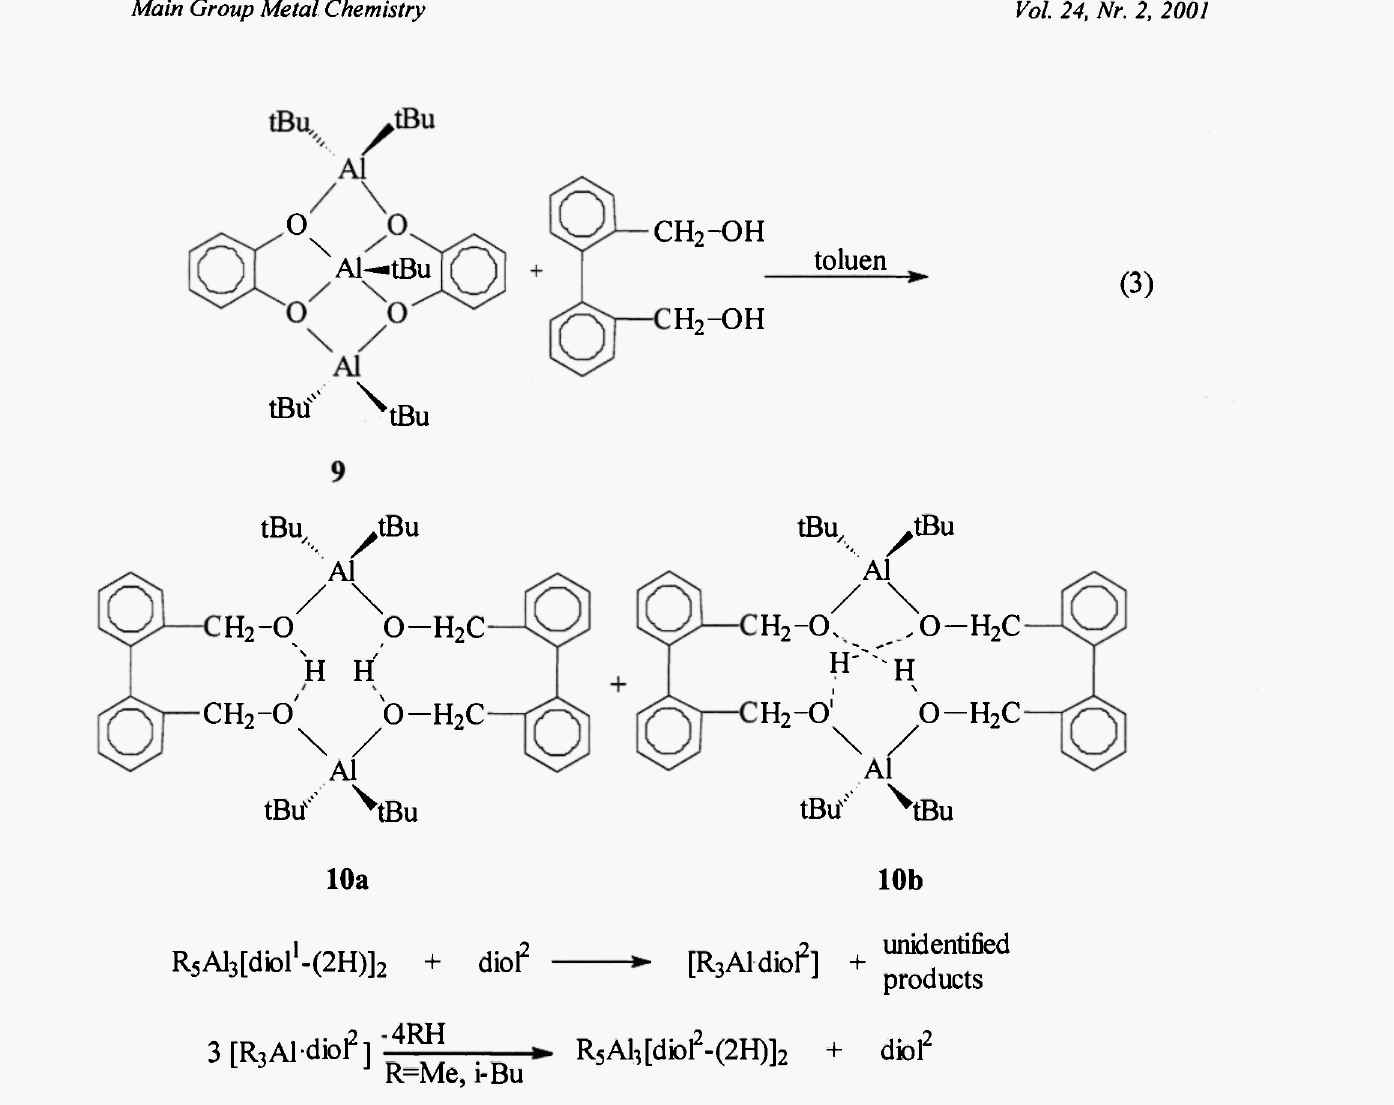
Scheme 1. Proposed pathway for the reaction of alkylaluminium diolates and catecholates with